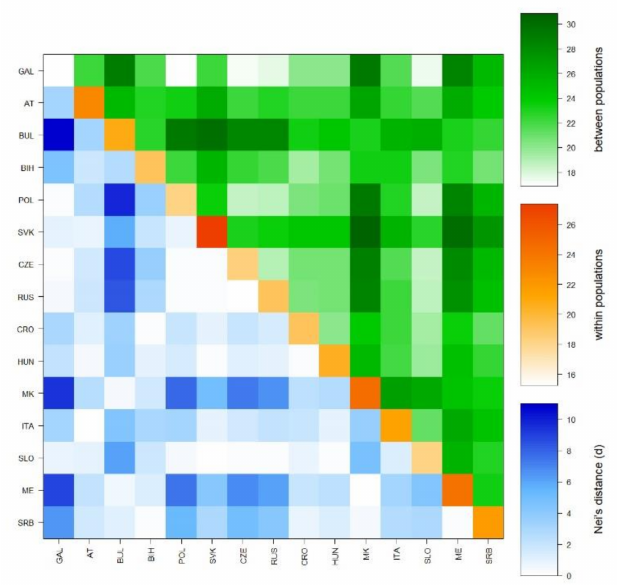
Figure 4. Heatmap based on the average number of pairwise di ff erences (Rst) between populations, within populations, and corrected average pairwise di ff erence.